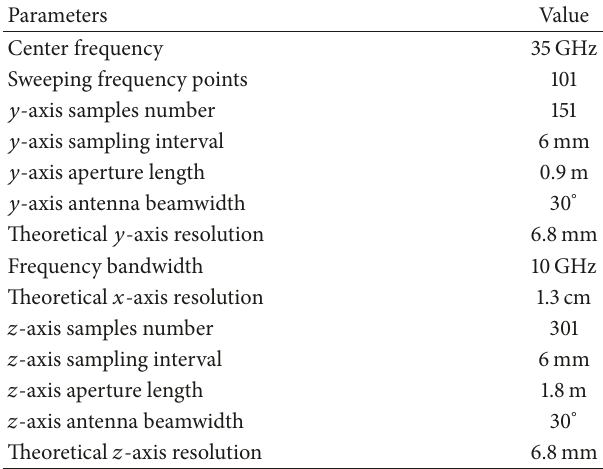
Table 1: Measurement parameters used in the simulation experi- ment.